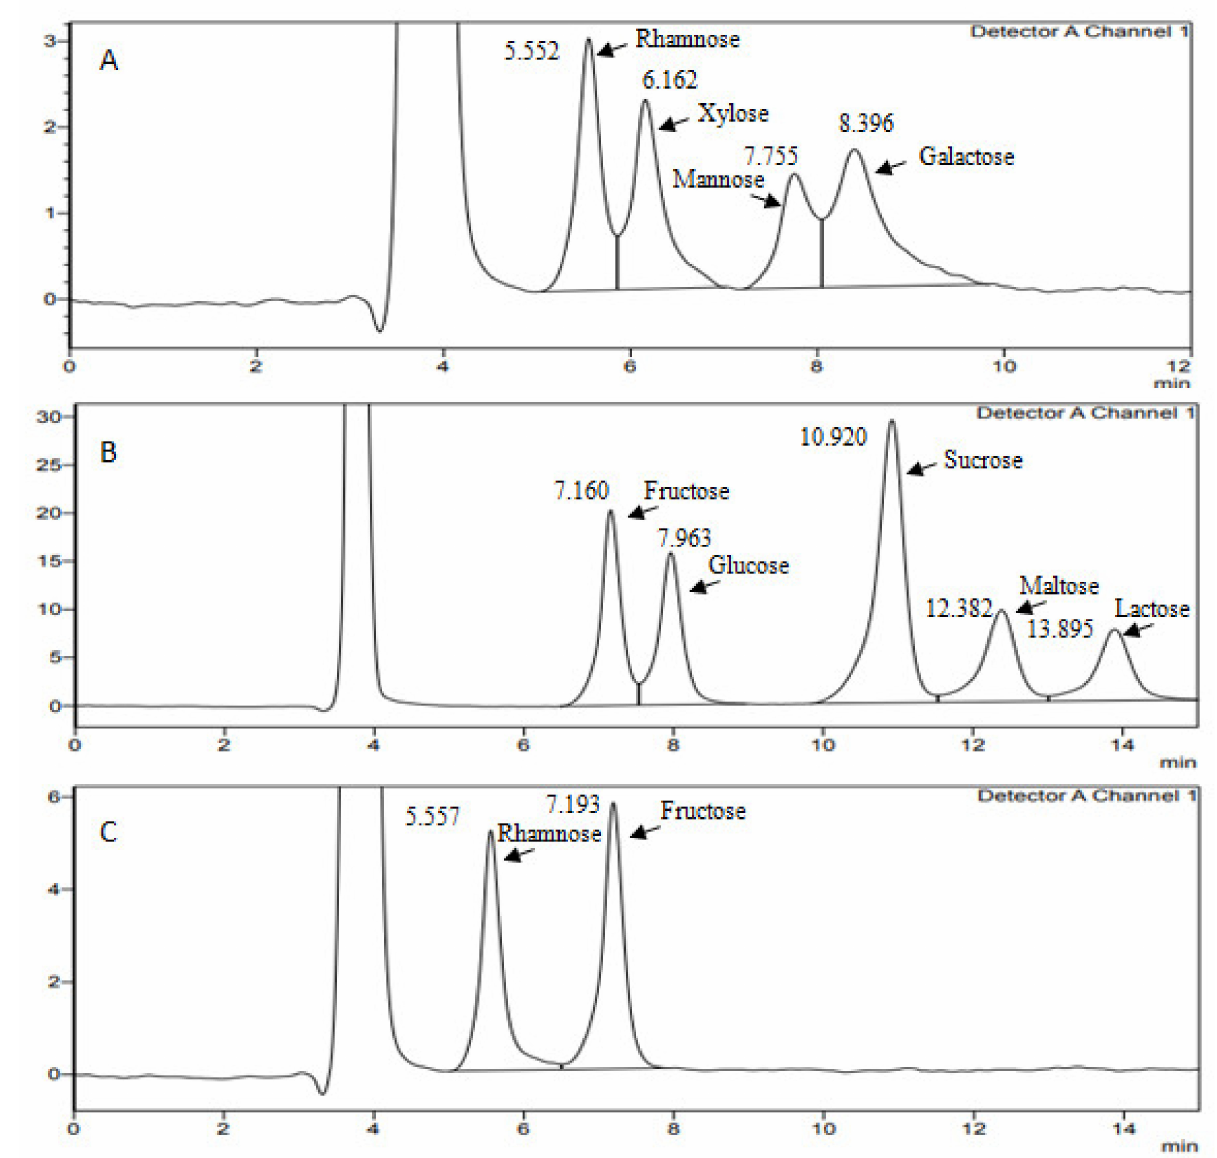
Figure 2. HPLC-RID chromatogram of ( A , B ) standard monosaccharides (rhamnose, xylose, mannose, glucose, galactose, fructose, sucrose, maltose, lactose) and ( C ) nEPS hydrolysate from H. desertis